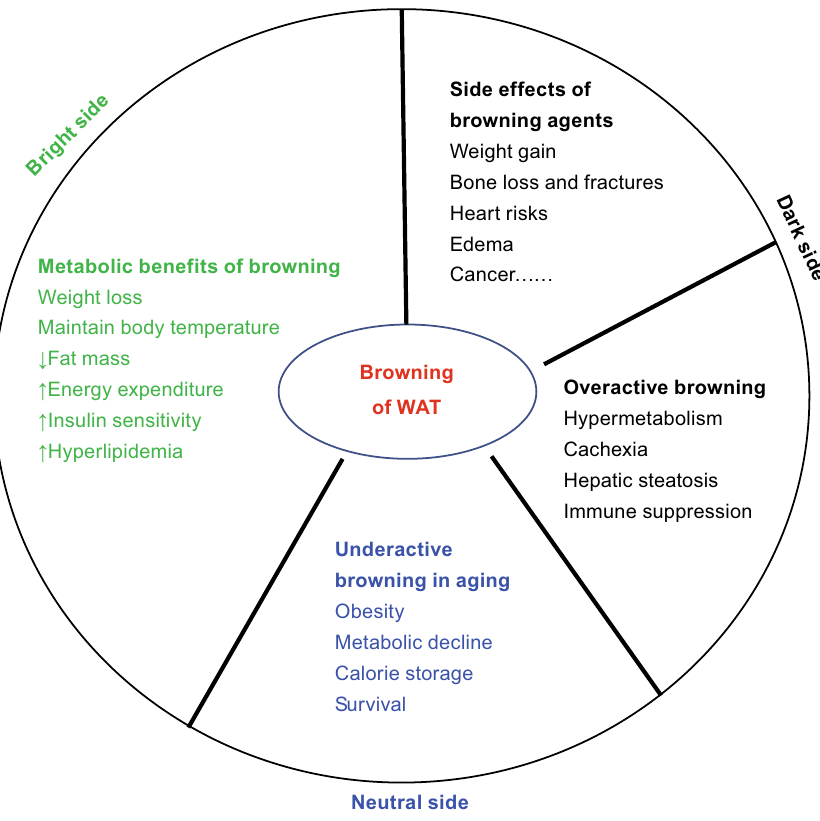
Figure 1. A summary of the metabolic bene fi ts and adverse outcomes associated with the induction of